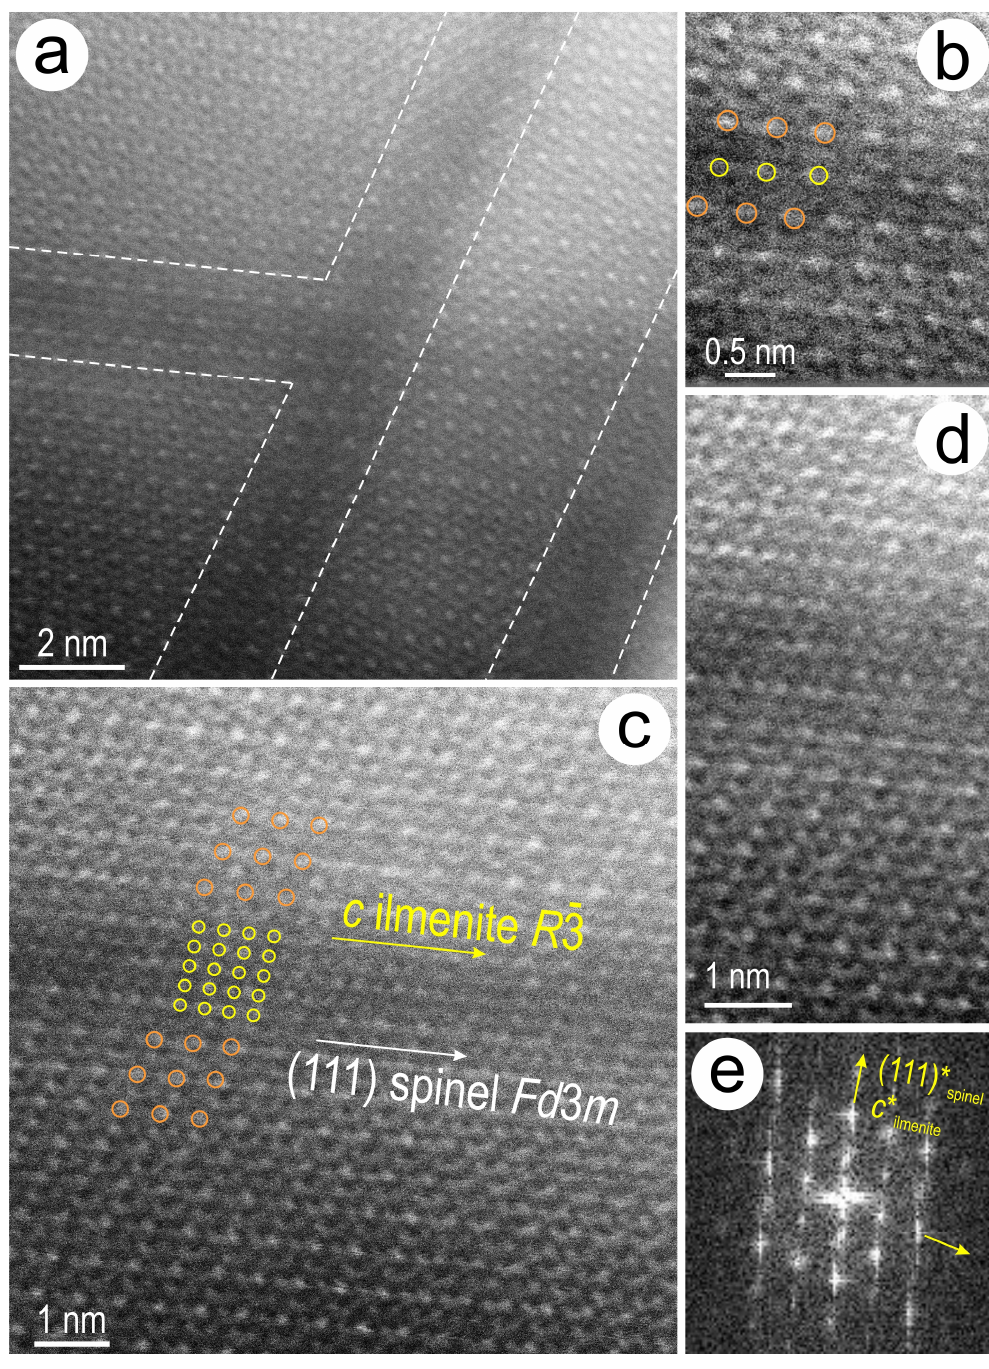
Figure 14. ( a , b ) High-resolution HAADF STEM images showing Ti-rich spinel crosscut by darker lamellae marked as dashed lines in ( a ). Details ( b ) show changes in atomic arrangement in spinel (cid:4670)11(cid:3364)0(cid:4671) across the lamellae. The loss in intensity for the 2Me M double-atom columns (yellow and orange circles) is observed across the one-unit, cell-wide lamella and is attributable to metal vacancies [26,27]. ( c ) High-resolution HAADF STEM image showing changes across a lamella where the structural motif in spinel (cid:4670)11 (cid:3364) 0(cid:4671) is no longer retained (only 2Me M marked). The image instead shows a motif with dumbbell atoms corresponding to ilmenite [010] (see Figure 11). ( d , e ) Crop and FFT from the image in ( c ) showing details of the image and the intergrowth between the spinel and ilmenite.